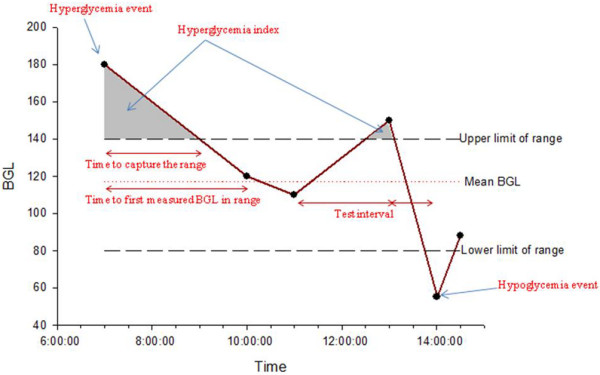
BGL measurements against time. Presented is a graph of hypothetical BGL measurements against time, showing hyperglycaemic and hypoglycaemic events, time to capture first (interpolated or measured) BGL in defined range, hyperglycaemic index and mean BGL.